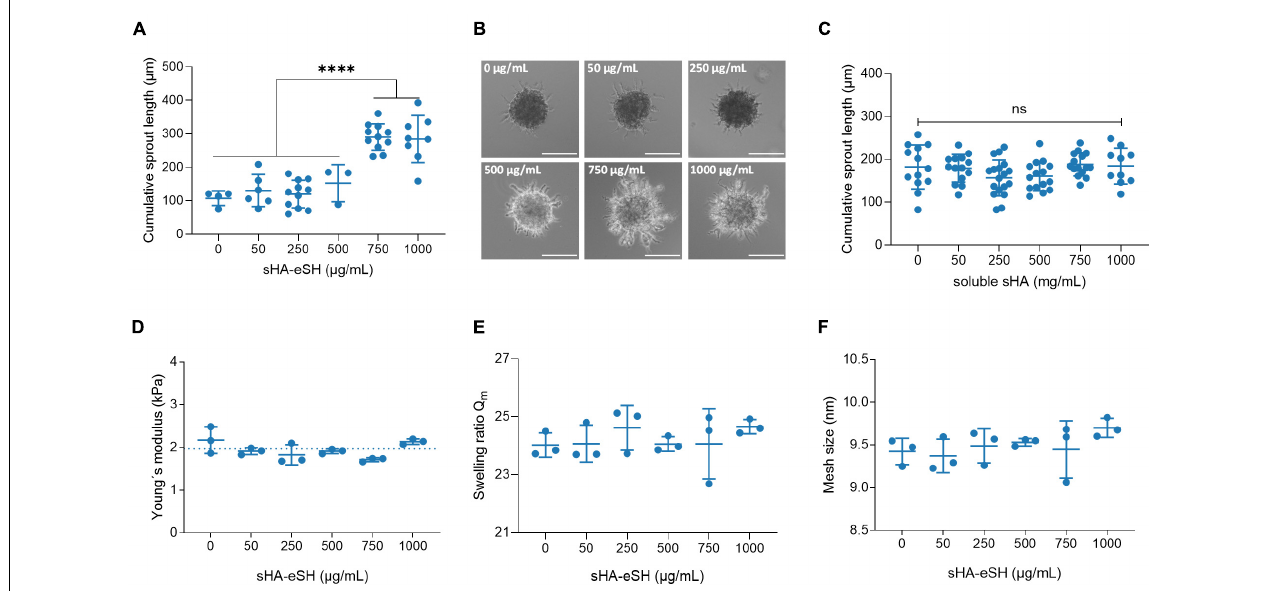
Figure 6 | Influence of immobilized sHA on angiogenic sprouting. (A) Analysis of the cumulative sprout length originating from HUVEC spheroids, embedded in 3.5 w/v% PEG hydrogel functionalized with 0.5 mM linRGD and varying concentrations of sHA-eSH. Spheroids were stimulated with 50 ng/mL VEGF for 48 h. Statistical significance was calculated using one-way ANOVA followed by Tukey’s test ( ∗∗∗∗ p < 0.0001, n ≥ 3). (B) Representative phase-contrast images of VEGF-induced sprouting of spheroids embedded in PEG/HA hydrogels. Scale bar 50 µ m. (C) Analysis of the cumulative sprout length originating from HUVEC spheroids, embedded in 3.5 w/v% PEG hydrogel functionalized with 0.5 mM linRGD and incubated with varying concentrations of freely diffusing sHA. (D) Bulk elasticity determined by shear rheological measurements, (E) swelling ratio of hydrogels in PBS and (F) mesh size of degradable 3.5 w/v% hydrogels prepared by thiol-Michael addition reaction with a MMP-cleavable di-cysteine peptide and functionalized with 0.5 mM linRGD and varying concentrations of sHA-eSH; mean and standard deviation of triplicates are